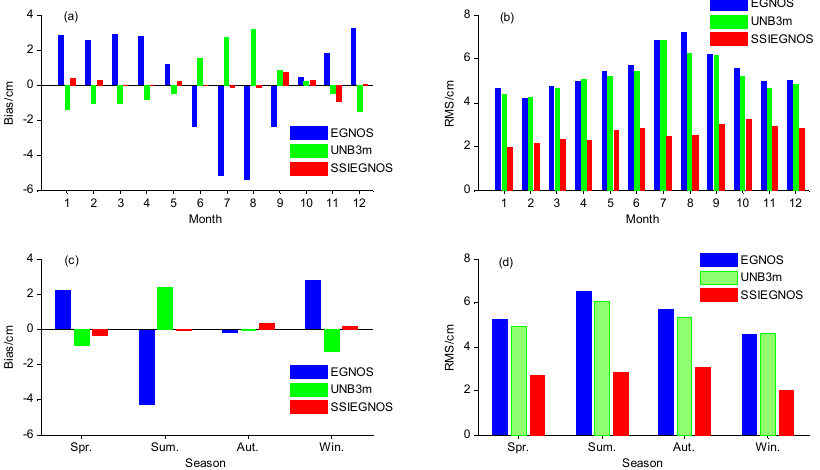
results are shown in Figure 11.